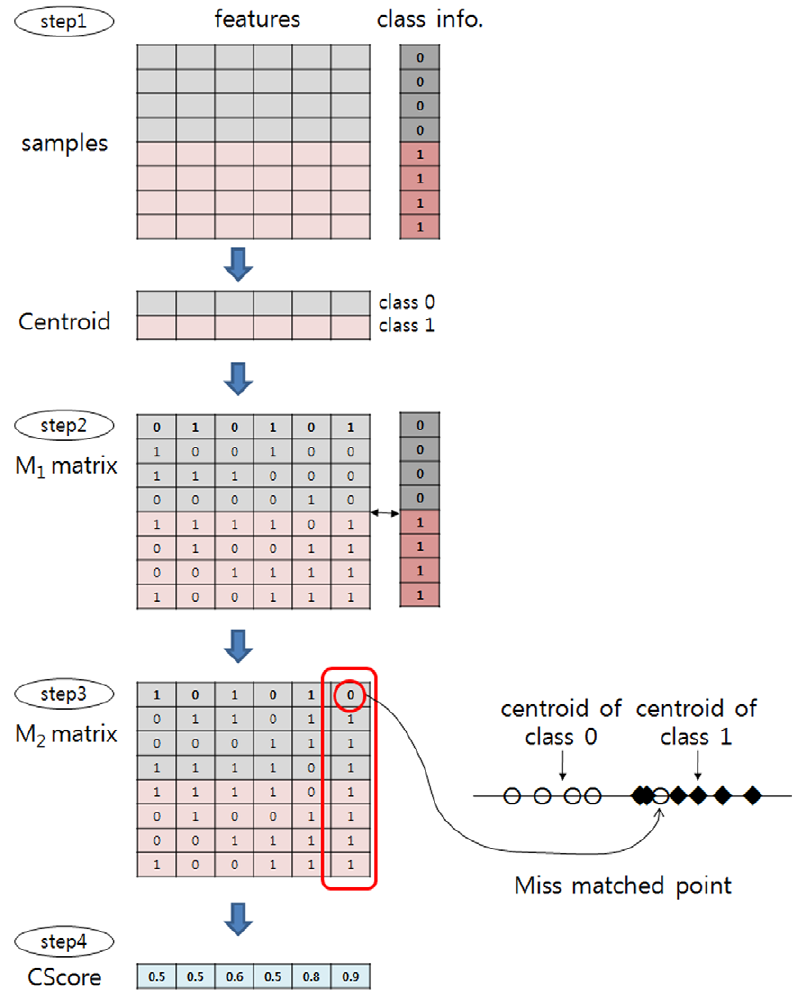
Figure 3. Procedure to get CScore().